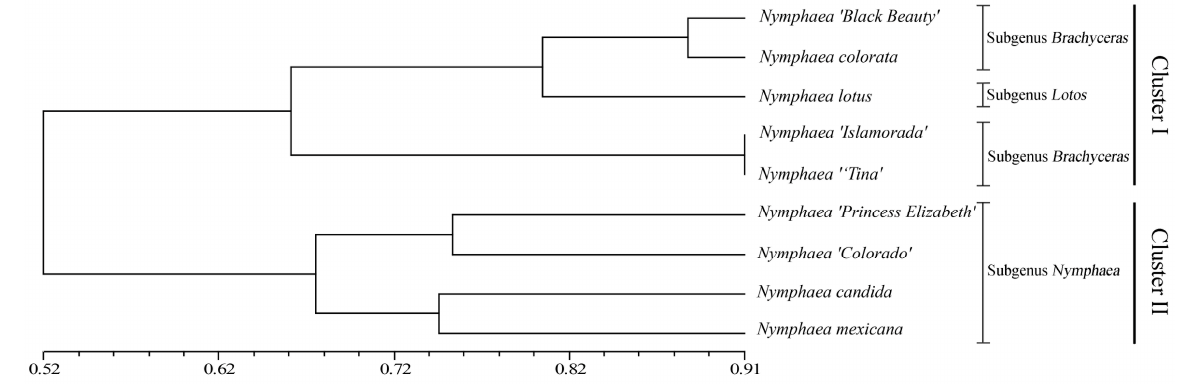
Figure 6. Cluster dendrogram of SSR markers of nine waterlily cultivars.